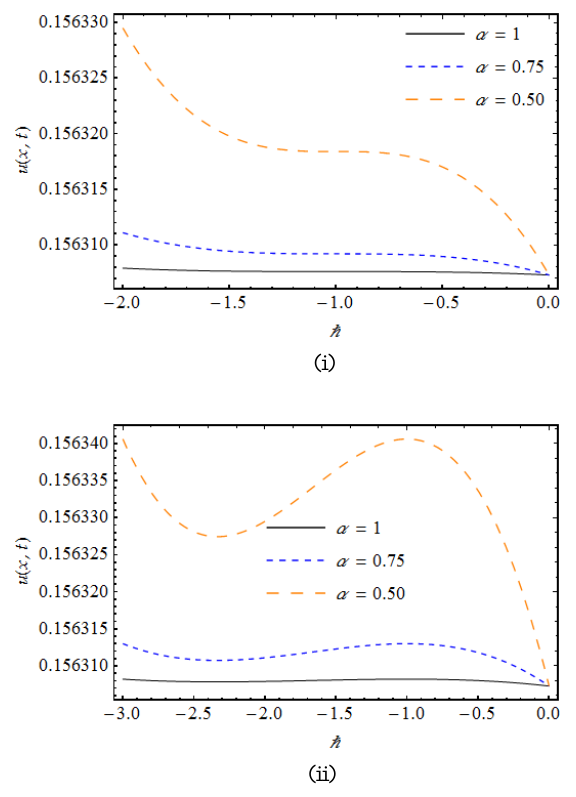
Figure 3. ℏ -curve for the acquired solution 𝑦(𝑥, 𝑡) versus ℏ for considered Ex. 1 when (i) 𝑛 = 1 and (ii) 𝑛 = 2 when 𝑎 = 1, 𝑘 = 0.1,𝑤 = 0.5,𝑡 = 0.001,𝑥 = 5 for distinct 𝛼 . Table 2. Absolute errors of ADM, HPM, OHAM [63], and the q -HAETM for Ex. 1 at 𝜶 = 𝟏, 𝒏 = 𝟏, 𝒌 = 𝟏,𝒂 = 𝟏,ℏ = −𝟏, 𝒘 = 𝟎.𝟓 and 𝒕 = 𝟎. 𝟎𝟎𝟏